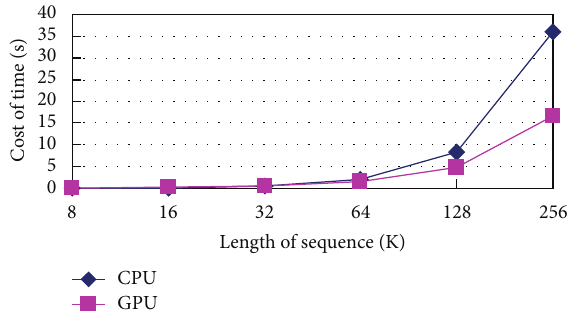
Figure 1: The average time comparison of computing whole ordinal at different lengths between CPU and GPU.